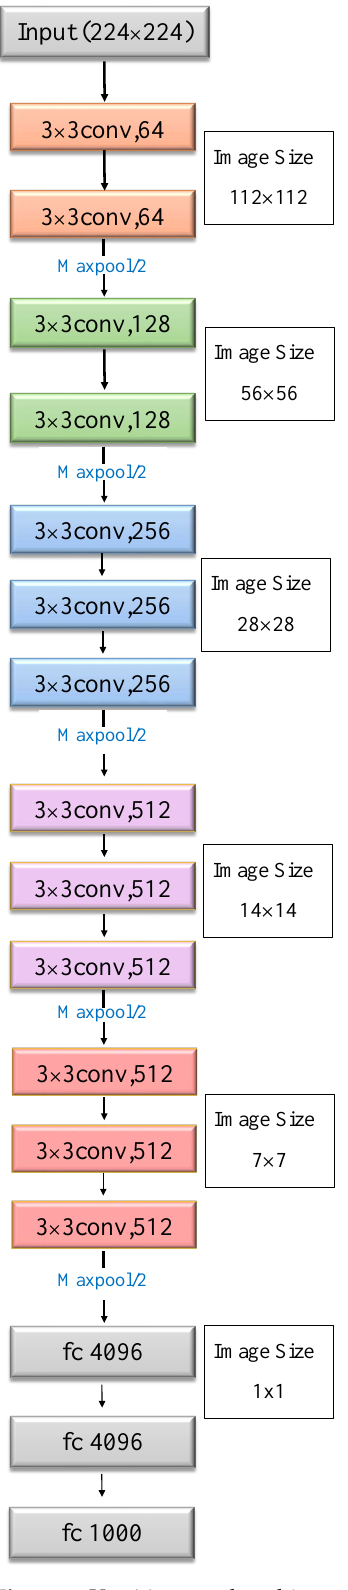
Figure 9. Vgg16 network architecture